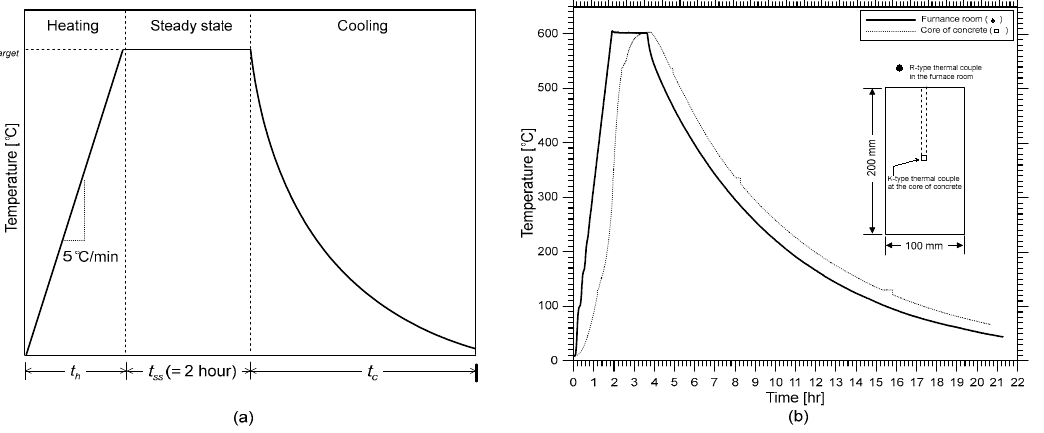
Figure 2. Temperature-time history used for this research: ( a ) programmed temperature-time history for heating electric furnace, ( b ) measured temperature in the air of the furnace and the core of a concrete cylinder for the target temperature of 600 °C. Note that t h is defined as the time it takes to reach the target temperature, t ss is the time when the temperature is sustained at T target (target temperature for this study, lasts for 2 h), and t c is the time it takes to naturally cool down to room temperature.